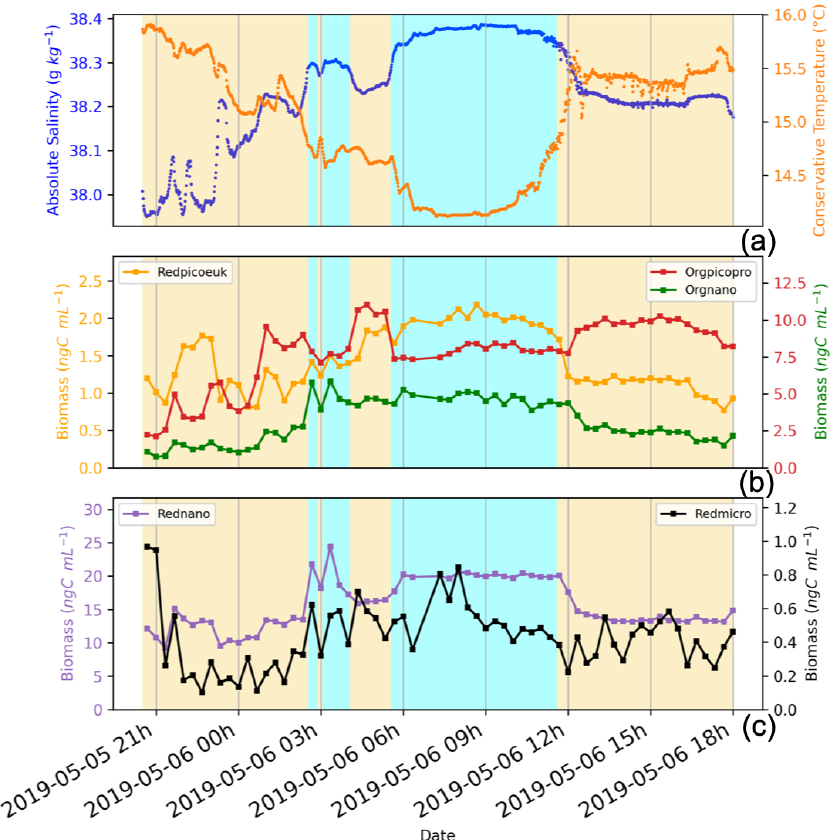
Figure 10. Illustration of the newly mixed waters (corresponding to the cyan background) and their direct surroundings (NC waters, corresponding to the yellow background), in terms of surface temperature, salinity, and biomass per phytoplankton group (ngCmL − 1 ). Panel (a) presents variation in the surface absolute salinity (blue dots) and surface conservative temperature (orange dots). Panel (b) shows variation in the surface biomass for the Redpicoeuk (orange line), Orgpicopro (red line), and Orgnano (green line) groups. Panel (c) presents variation in the surface biomass for the Rednano (violet line) and Redmicro (black line) groups. The vertical axis label colours indicate the associated curve. Similarly, labels and titles written in two different colours indicate that two curves are associated with the same axis.